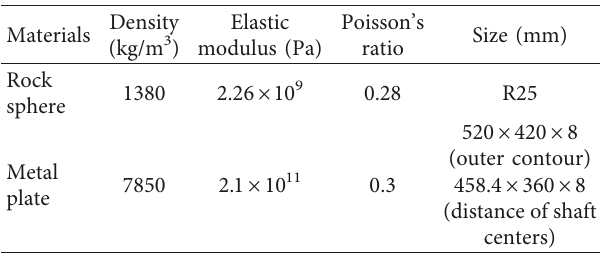
Table 1: Materials